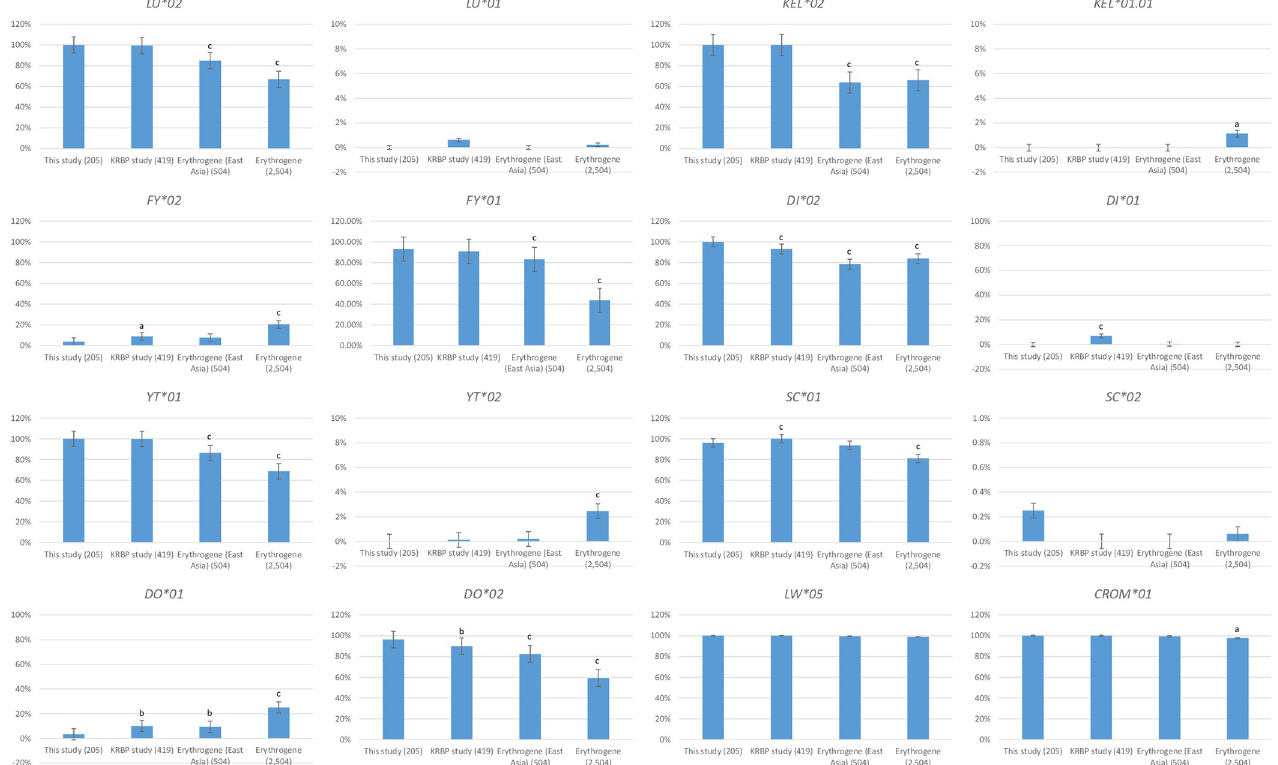
Fig 1. Comparison analysis of allele frequencies between this study, KRBP and Erythrogene data. Allele frequencies of Lutheran, Kell, Duffy ( FY � 01 ), Yt, Landsteiner-Wiener, and Cromer blood group systems showed no significant differences between this study and KRBP study. However, the allele frequencies of Lutheran, Kell, Duffy ( FY � 01 ), and Yt blood group systems showed significant differences from the Erythogene (East Asian and all races) data and allele frequency of Cromer blood group system showed significant difference from the Erythrogene (all races). The high-frequency alleles LU � 02 , KEL � 02 , FY � 01 , YT � 01 , SC � 01 , DO � 02 , and CROM � 01 were more frequent in Koreans than in East Asians or all races in the Erythrogene database. a P value < 0.05 between this study compared to KRBP, Erythrogene (East Asia), or Erythrogene; b P value < 0.01 between this study compared to KRBP, Erythrogene (East Asia), or Erythrogene; c P value < 0.001 between this study compared to KRBP, Erythrogene (East Asia), or Erythrogene. Abbreviation: KRBP, Korean rare blood